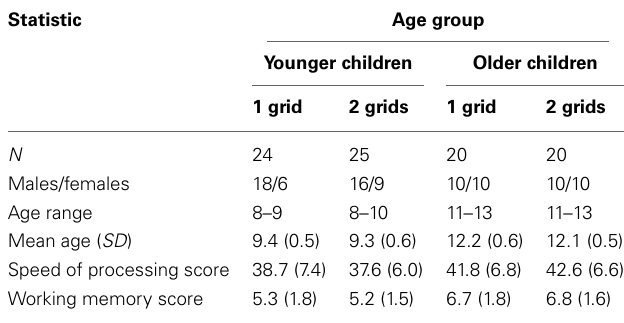
Table 1 | Descriptive statistics for the